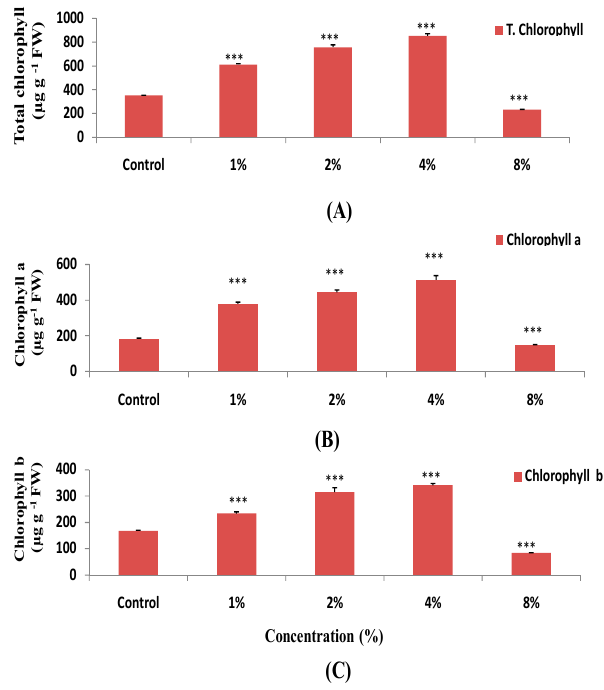
Figure 5. Effect of the aqueous extract of H. persicum on photosynthetic pigments in wheat. Total chlorophyll ( A ), chlorophyll a ( B ), and chlorophyll b ( C ). *** = very highly significant. The effect of allelochemicals on the content of photosynthetic pigments varies ac- cording to the recipient species and the qualitative and quantitative content of the alle- lochemicals of the donor species [19,26,28,68,69]. In our study, the allelopathic stress of H. persicum significantly enhanced the level of chlorophyll a and b under the low and mod- erate content of allelochemicals, whereas the highest concentration of allelochemicals (8%) intensively reduced the content of chlorophyll a and b in wheat seedlings. The reduction in chlorophyll a and b in wheat under allelochemicals stress is well reported in various wheat cultivars [56], including Pirsabaq, Serin, and Ata Habibin, Pakistan [68]. Furthermore, the seedlings of two different wheat varieties exposed to Helianthus annus allelochemicals also demonstrated a significant reduction in chlorophyll a and b [63]. 3.3. Effect of H. persicum on Carbohydrates and Proline Contents in Wheat Carbohydrate content was significantly reduced under the lowest concentration (1%), whereas no significant change was recorded under other treatments (Figure 6A). On the contrary to carbohydrates, the content of proline was significantly increased in response to all treatments, with an increase with increasing extract concentration from 1% to 4% (Figure